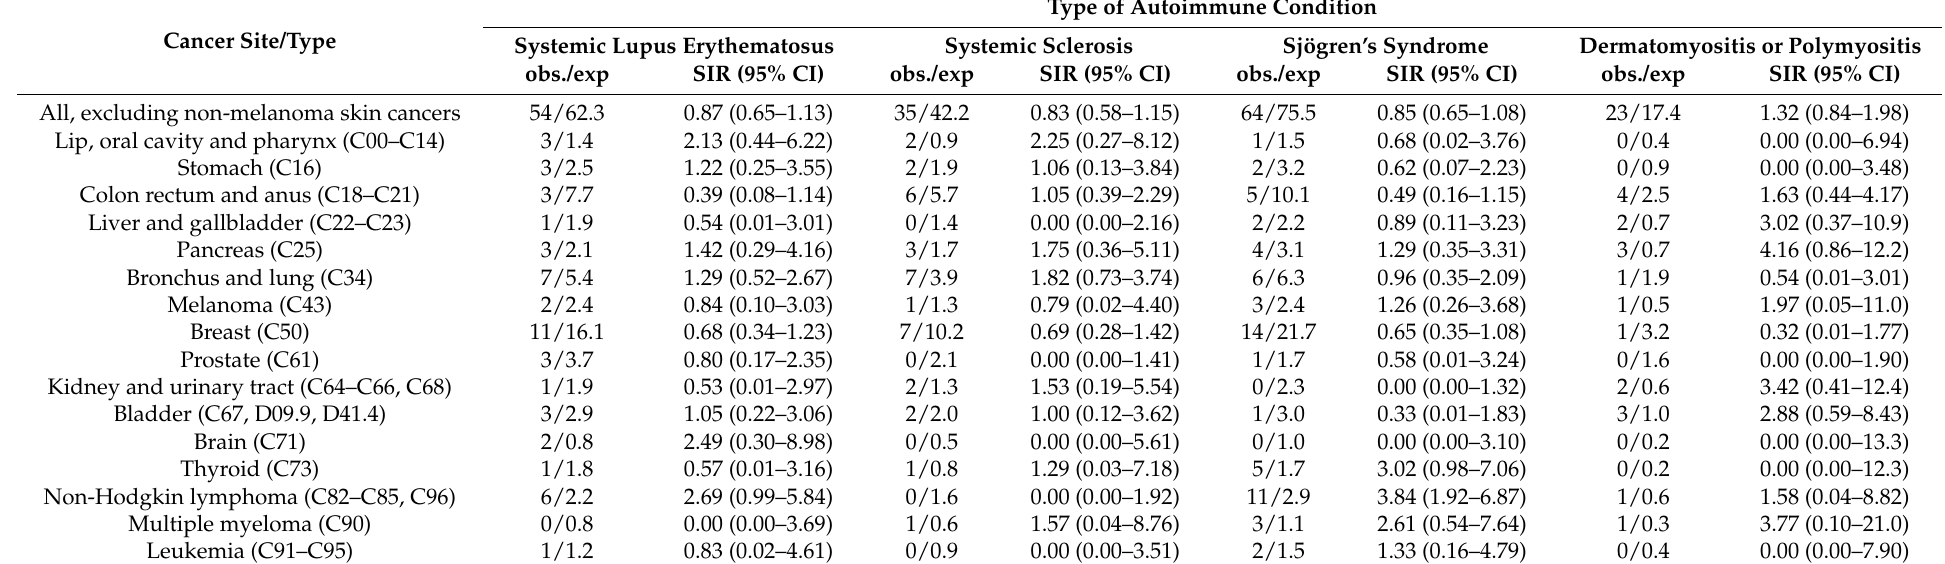
Table 3. Standardized incidence ratios (SIRs) and 95% confidence intervals (CIs) for de novo malignancies by cancer site/type and autoimmune condition.